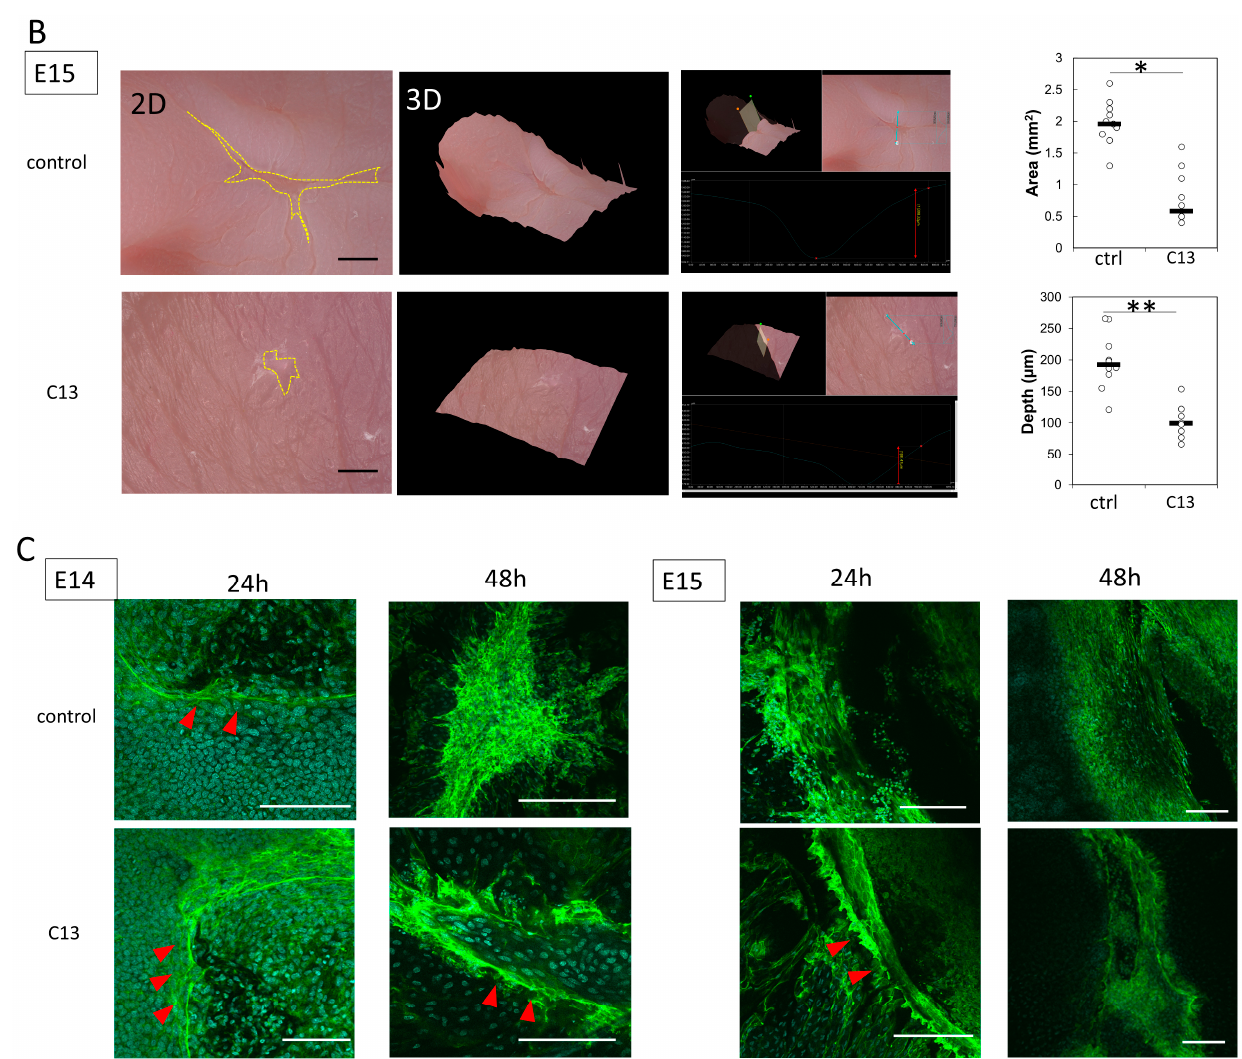
Figure 1. The effect of C13 administration on fetal mouse wound healing. ( A ) Wound evaluation of salicylic acid administration at E14 (bar, 500 µm), ( B ) wound evaluation of salicylic acid administration at E15, and ( C ) microscopic observation of actin cable formation during wound healing in E14 and E15 mouse fetuses. Green fluorescence is phalloidin, indicating actin filaments, and red arrows indicate areas of actin cable formation (bar, 20 µm). Ctrl, control; C13, compound 13. * p < 0.05, and ** p < 0.01.